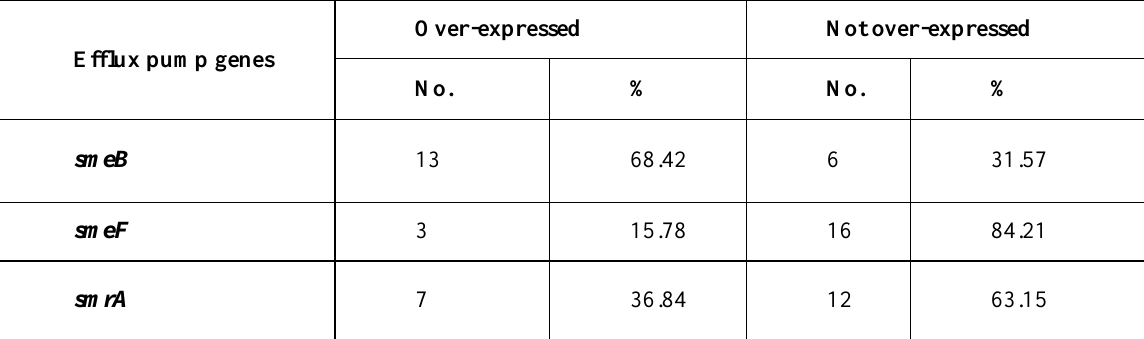
Table 3. Level of expression of smeB , smeF and smrA genes among the 19 S. maltophilia